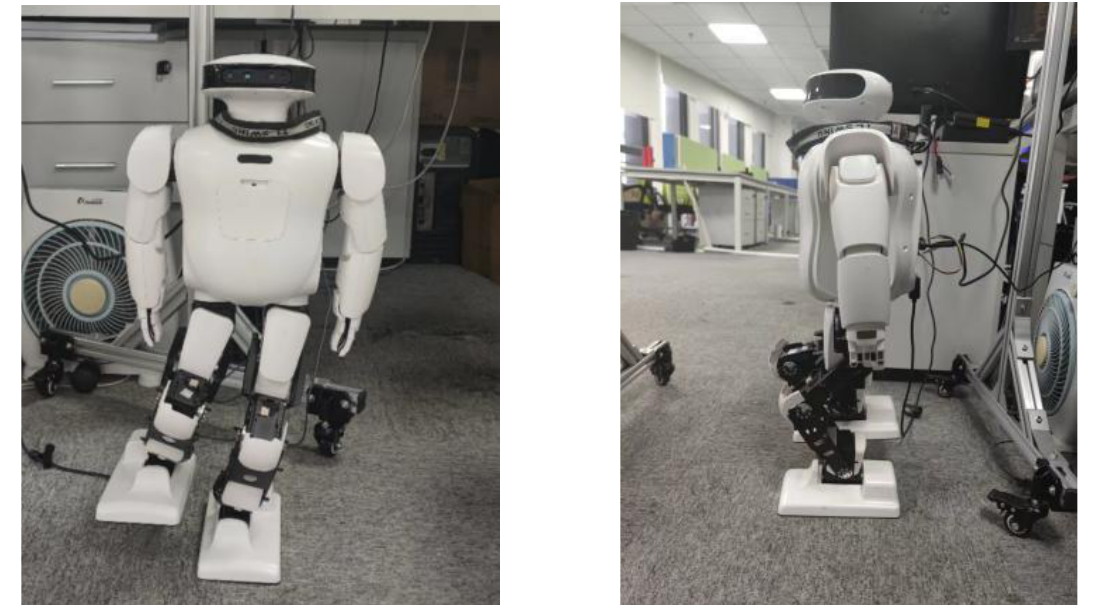
Figure 9. Roban standing on a single leg with spring compensation.